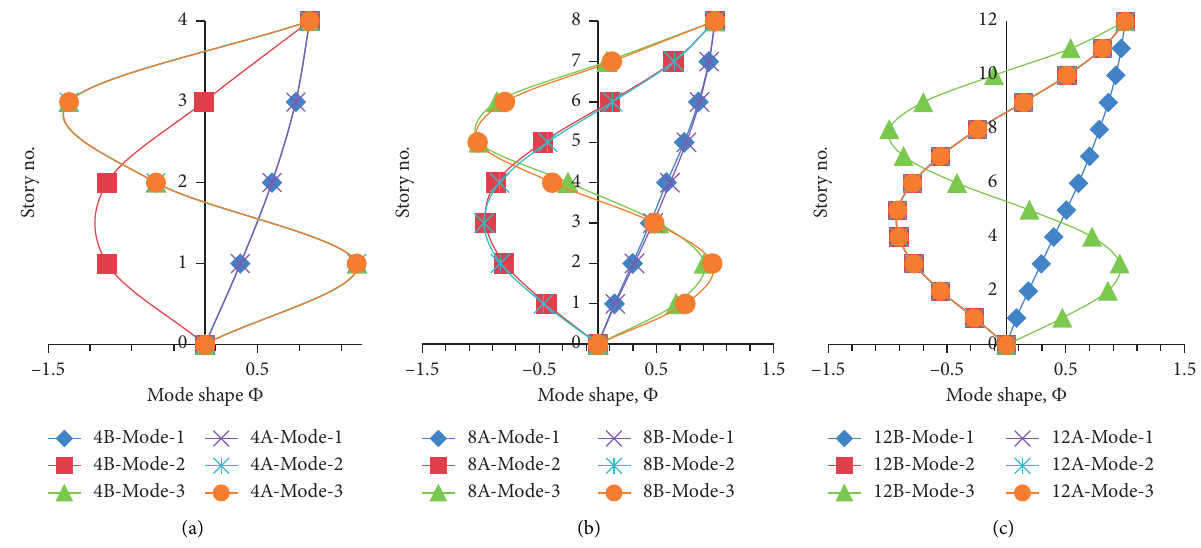
Figure 3: Modal shapes: (a) 4-(A, B), (b) 8-(A, B), and (c) 12-(A, B) story model Table 1: Seismic masses, natural periods, and modal participating mass (MPM (%)). Structures